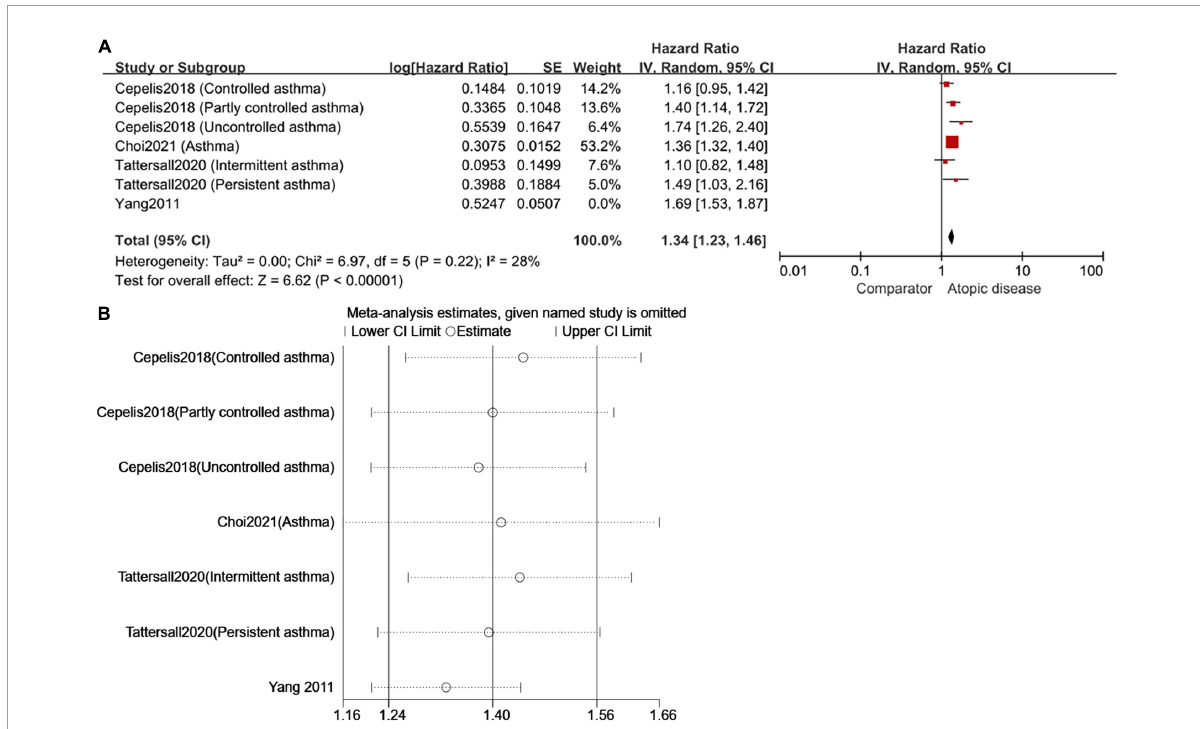
FIGURE6 To repeat the sensitivity analysis, the image used two types of software [ (A) RevMan 5.3 and (B) STATA 15.0]. As expected, the results were consistent and suggested that Yang et al. (18) was the main factor of high heterogeneity in the meta-analysis of cohort studies on AF risk in asthmatic